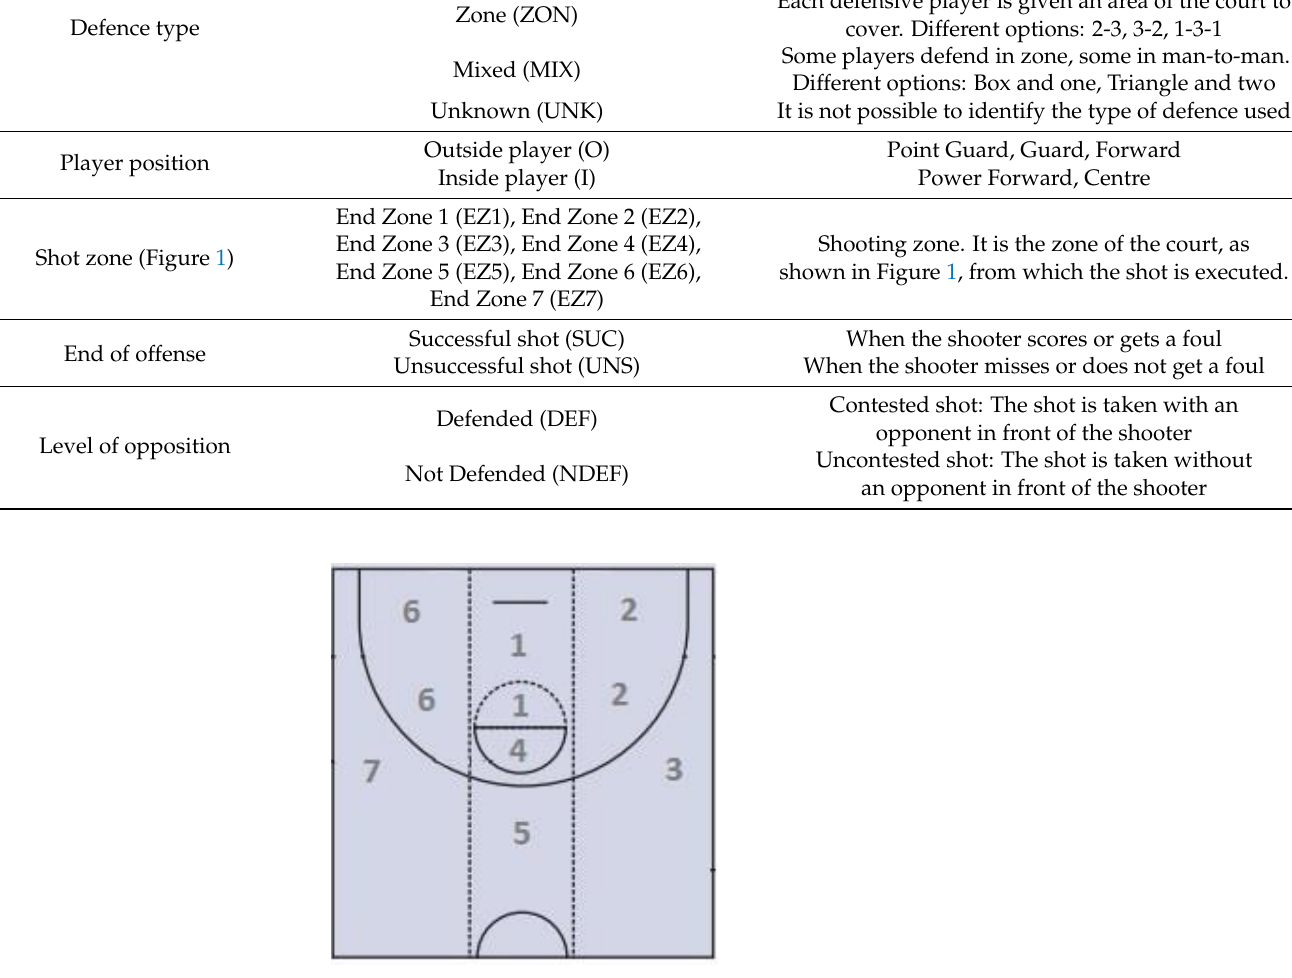
Figure 1. Shot zone.